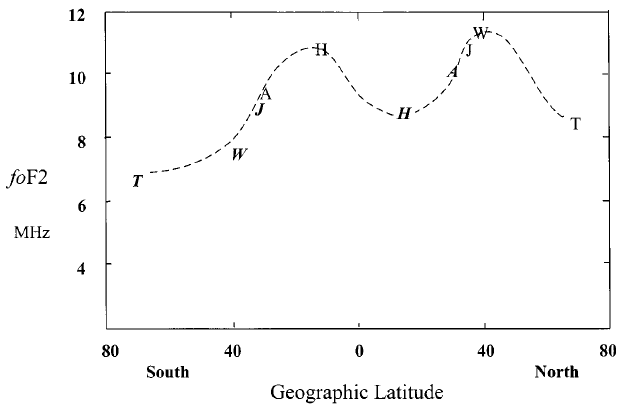
Fig. 2. Midday critical frequency f oF2 at solstice in 1937/38, using data from Tromsø ( T , 70 (cid:176) N), Washington ( W , 39 (cid:176) N), Hiraiso ( J , 36 (cid:176) N), Huancayo ( H , 12 (cid:176) S), and Watheroo ( A , 30 (cid:176) S). The roman letters show December/January values from the northern stations and June/July data from the southern stations, plotted in their correct hemispheres. The italic letters show June/July values from the northern stations and December/January values from the southern stations, plotted in their opposite hemispheres. After Namba and Maeda